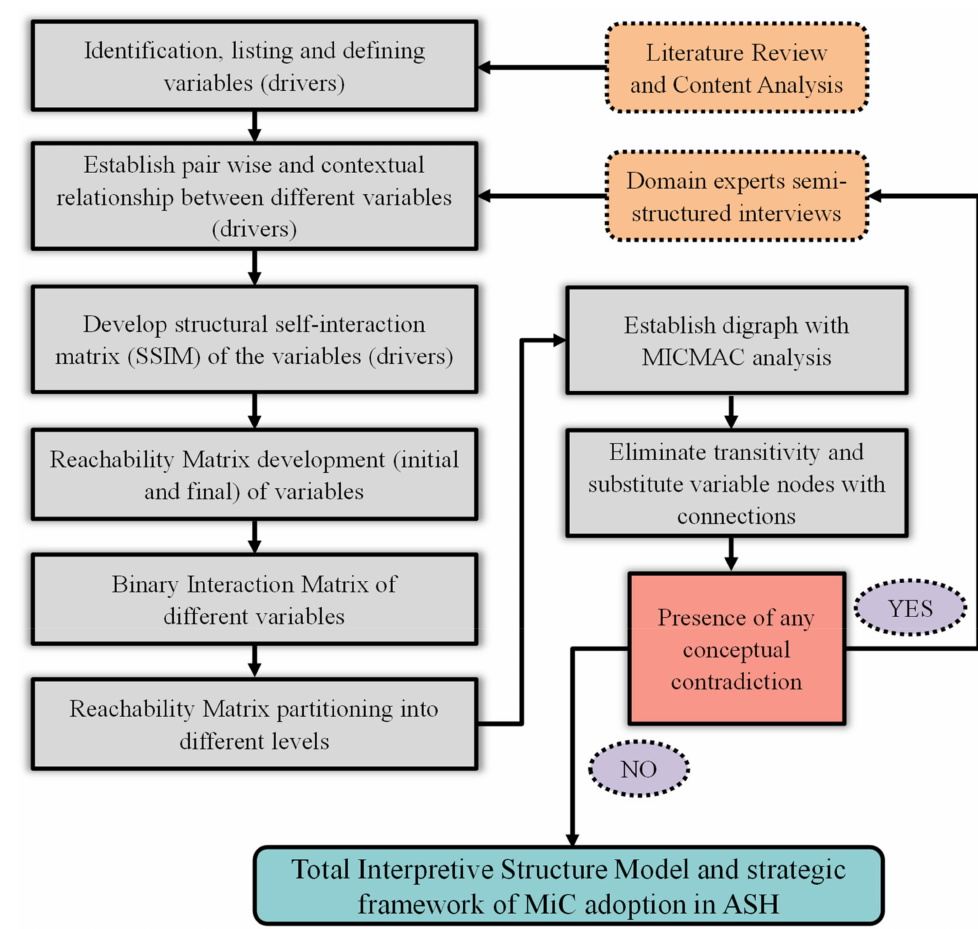
Figure 5. Steps in TISM